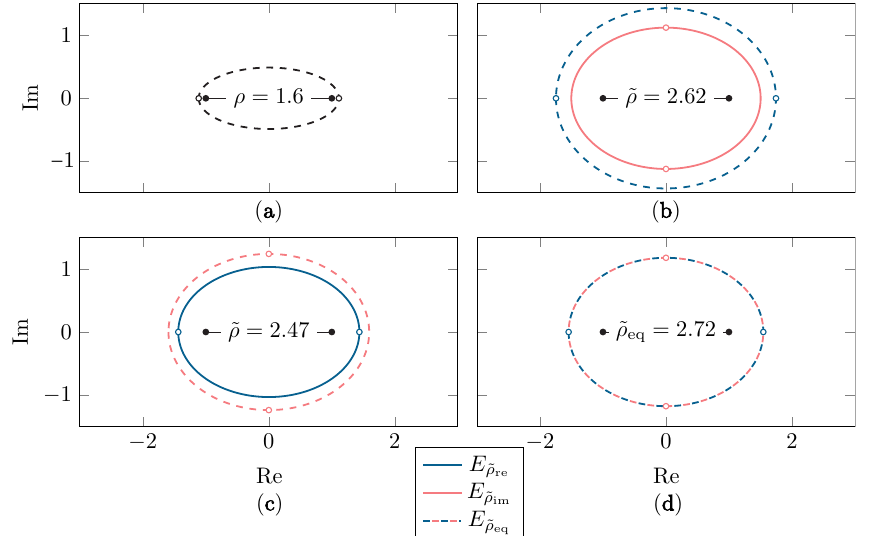
1.1125) in the x -space ± and E ˜ ρ when using κ = 1.05 κ eq ( b ), κ = 0.95 κ eq re im